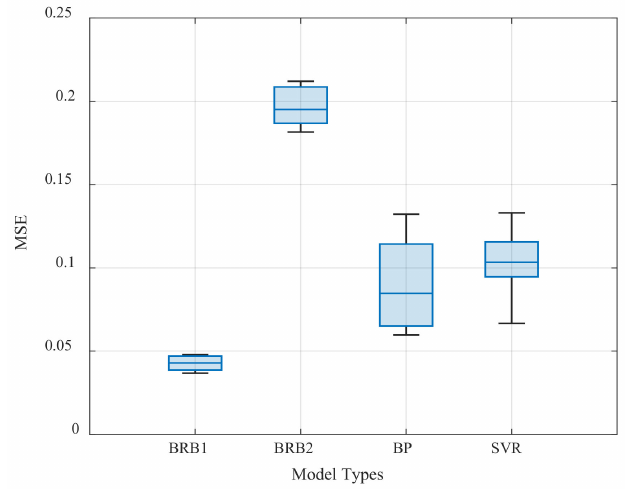
Figure 13. Comparison of stability of the four